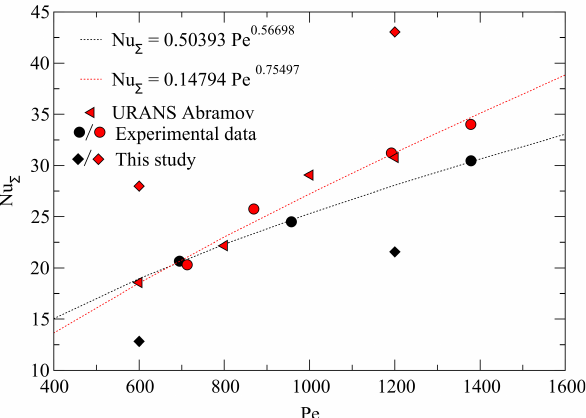
Figure 3. Arithmetic average Nu Σ plotted against Pe for S-RANS simulations: compact (black) and wide (red) tube bank. Dashed lines mark regression of experimental data presented in [14]. Relevant URANS results, also from [14], are plotted for comparison.